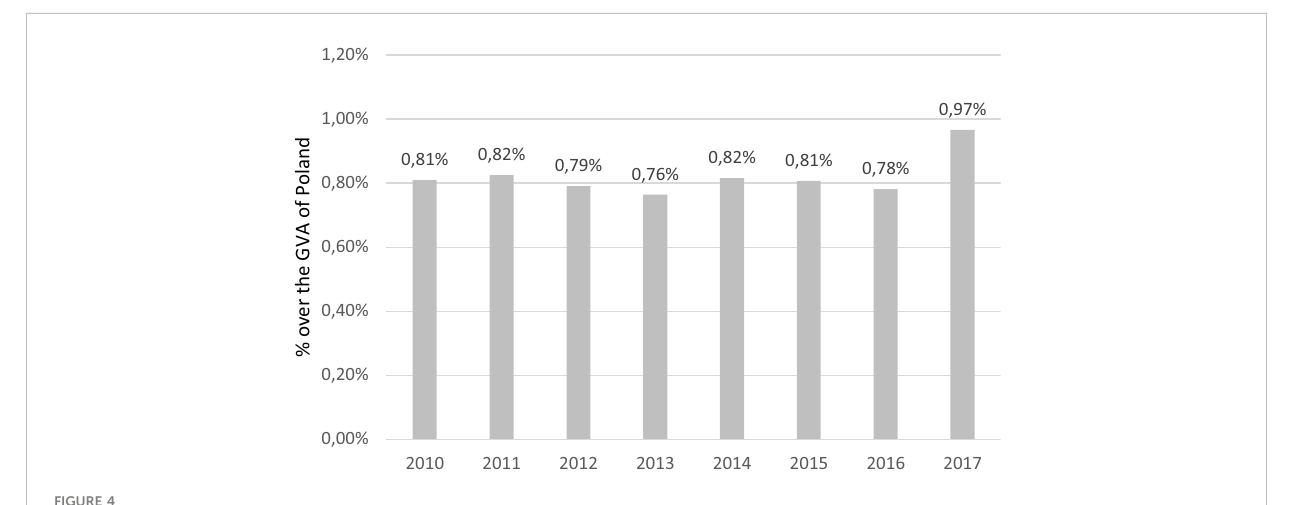
FIGURE 4 The blue economy as a share of the total Polish economy. Source: own